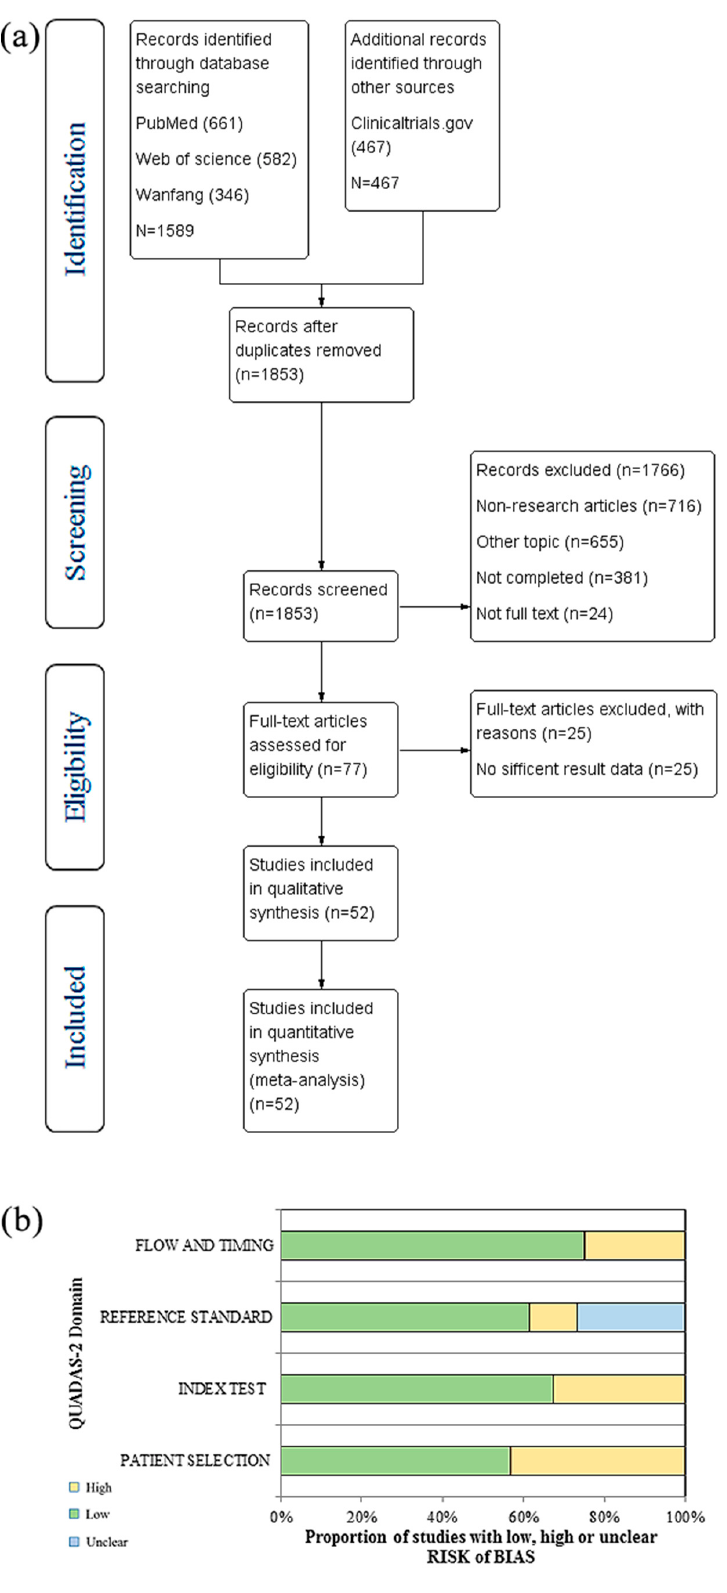
Figure 1. Research results and quality assessment: ( a ) Flow-diagram of the literature selection process; ( b ) Results of the methodologic assessment by using the Quality Assessment of Diagnostic Accuracy Studies (QUADAS-2) tools.